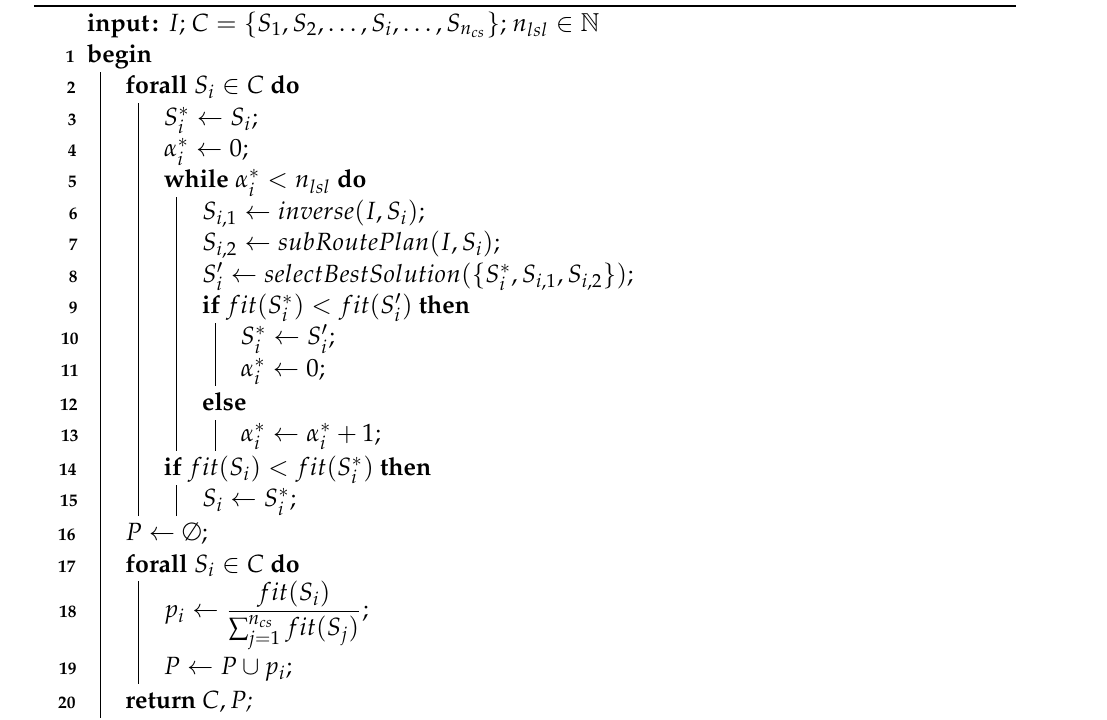
Algorithm 3: employedBP (Employed Bee Phase of the CARP-ABC